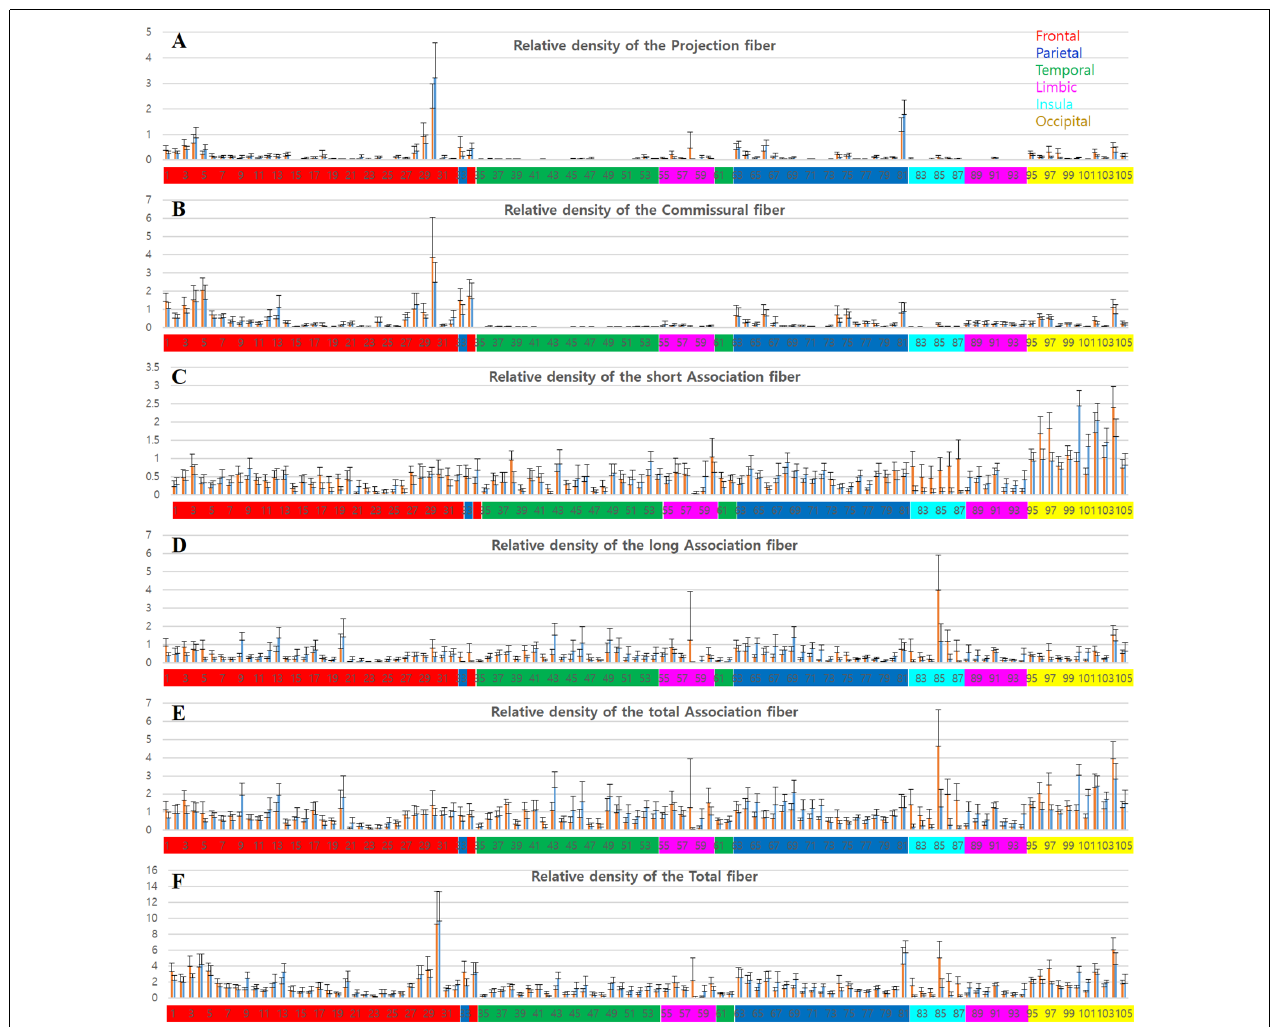
FIGURE 4 | Graphs of the tracks density in each parcellation-piece from all 16 datasets per parcellation-piece. The X-axes indicate the parcellation label of the Brainnetome Atlas (see Supplementary Figure 1 and Supplementary Table 1 ). The label numbers were coded by color depending on the lobes of the brain as follows: frontal lobe (red), parietal lobe (blue), temporal lobe (green), limbic lobe (magenta), insular lobe (cyan), and occipital lobe (yellow). The Y-axes indicate the relative density of the tracks in the volume (tracks_amount/piece_volume). The bar in the left-side (red) and right-side (blue) in each label number is the results from the left and right hemispheres, respectively. (A–E) Mean and standard deviation of the relative track-density for the (A) projection, (B) commissural, (C) short association, (D) long association, (E) total association, and (F) total